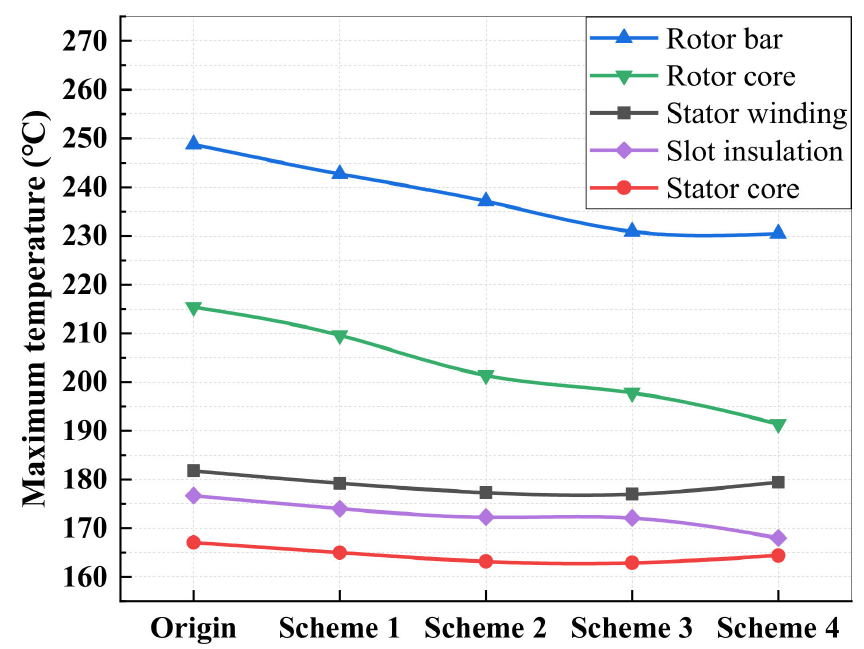
Figure 8. Temperature comparison of nonlinear variable cross-section stator ventilation